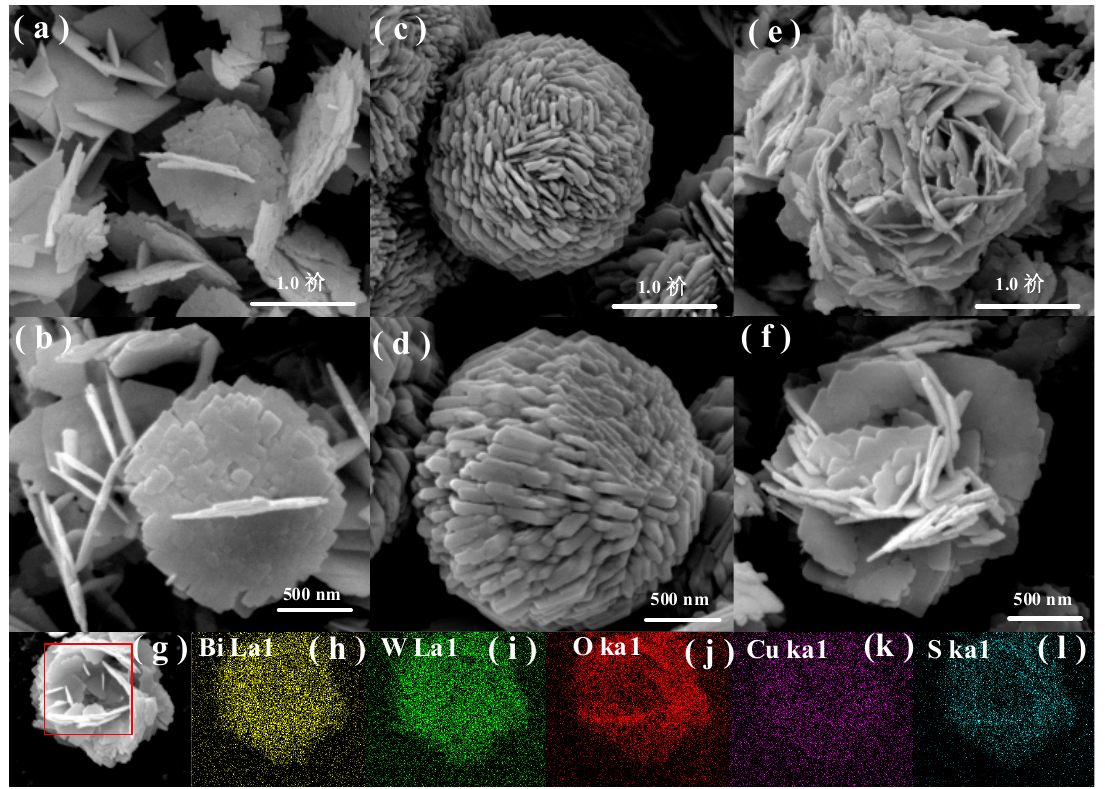
Figure 3. FESEM images of ( a , b ) Bi 2 WO 6 , ( c , d ) CuS, and ( e , f ) 0.1% CuS/Bi 2 WO 6 heterostructure, and energy filtered elemental mapping of 0.1% CuS/Bi 2 WO 6 heterostructure ( g – l ).